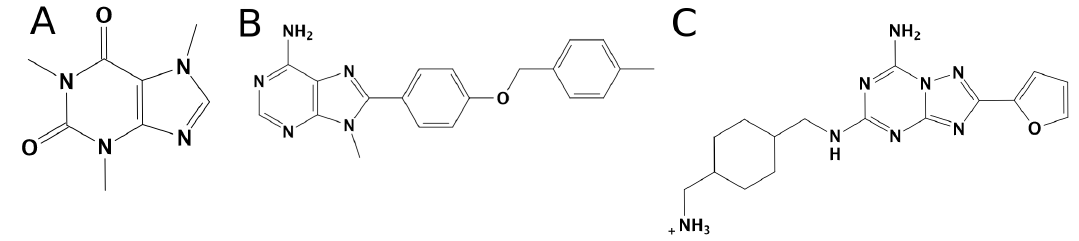
Figure 2. The three ligands considered in the present study. ( A ) Ca ff eine, a non-selective ARs antagonist. ( B ) LC4, an A 1 -AR selective antagonist. ( C ) Z48, an A 2A -AR selective antagonist.